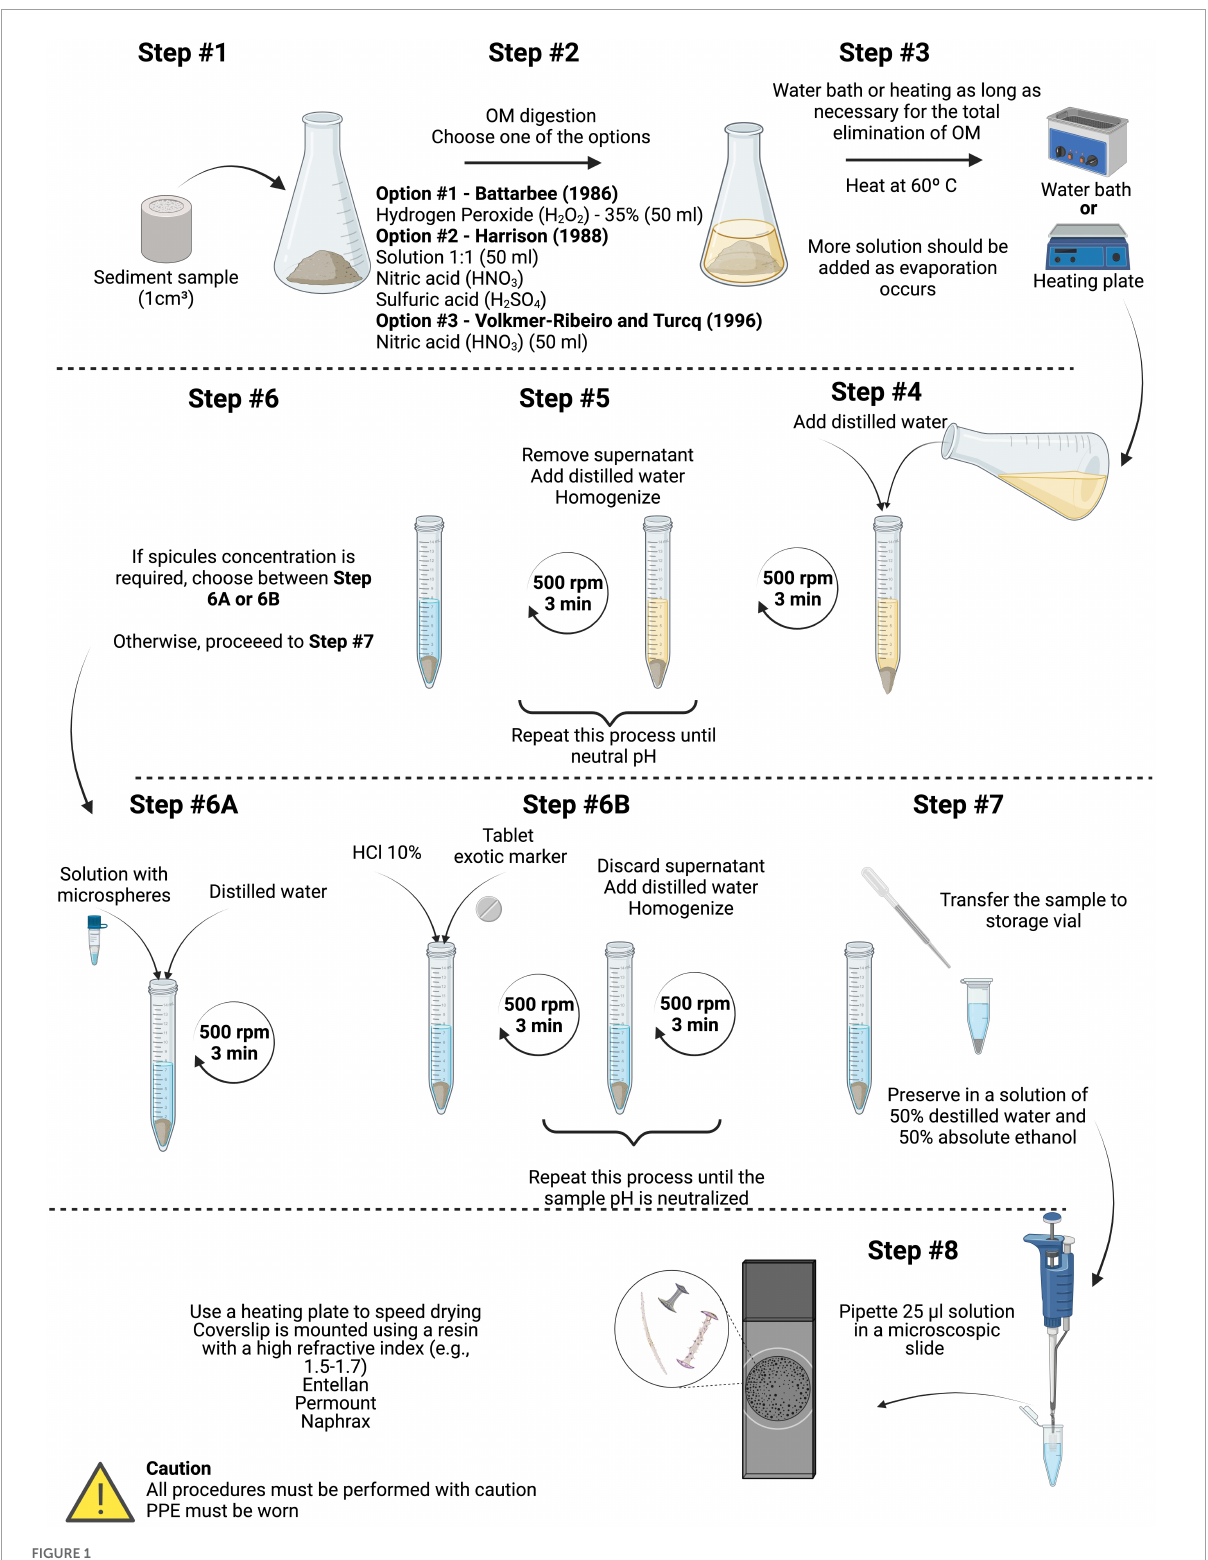
FIGURE1 Flow chart of the wet oxidation method of extracting sponge spicules from sediments. Methodology adapted from Battarbee (1986), Harrison (1988), and Volkmer-Ribeiro and Turcq (1996). OM, organic matter; PPE, personal protective equipment.